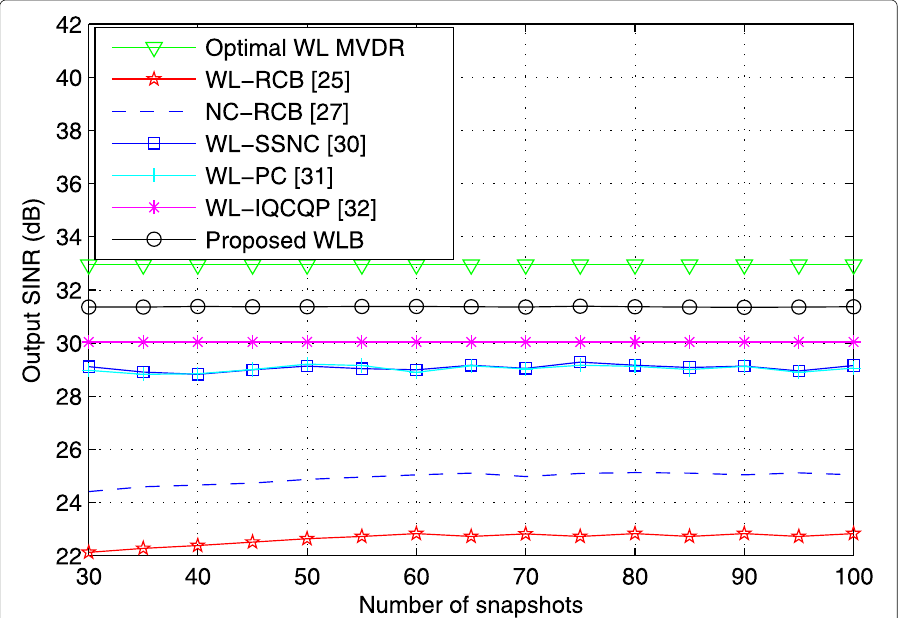
Fig. 11 Example 5. Output SINR of all WLBs versus the number of snapshots